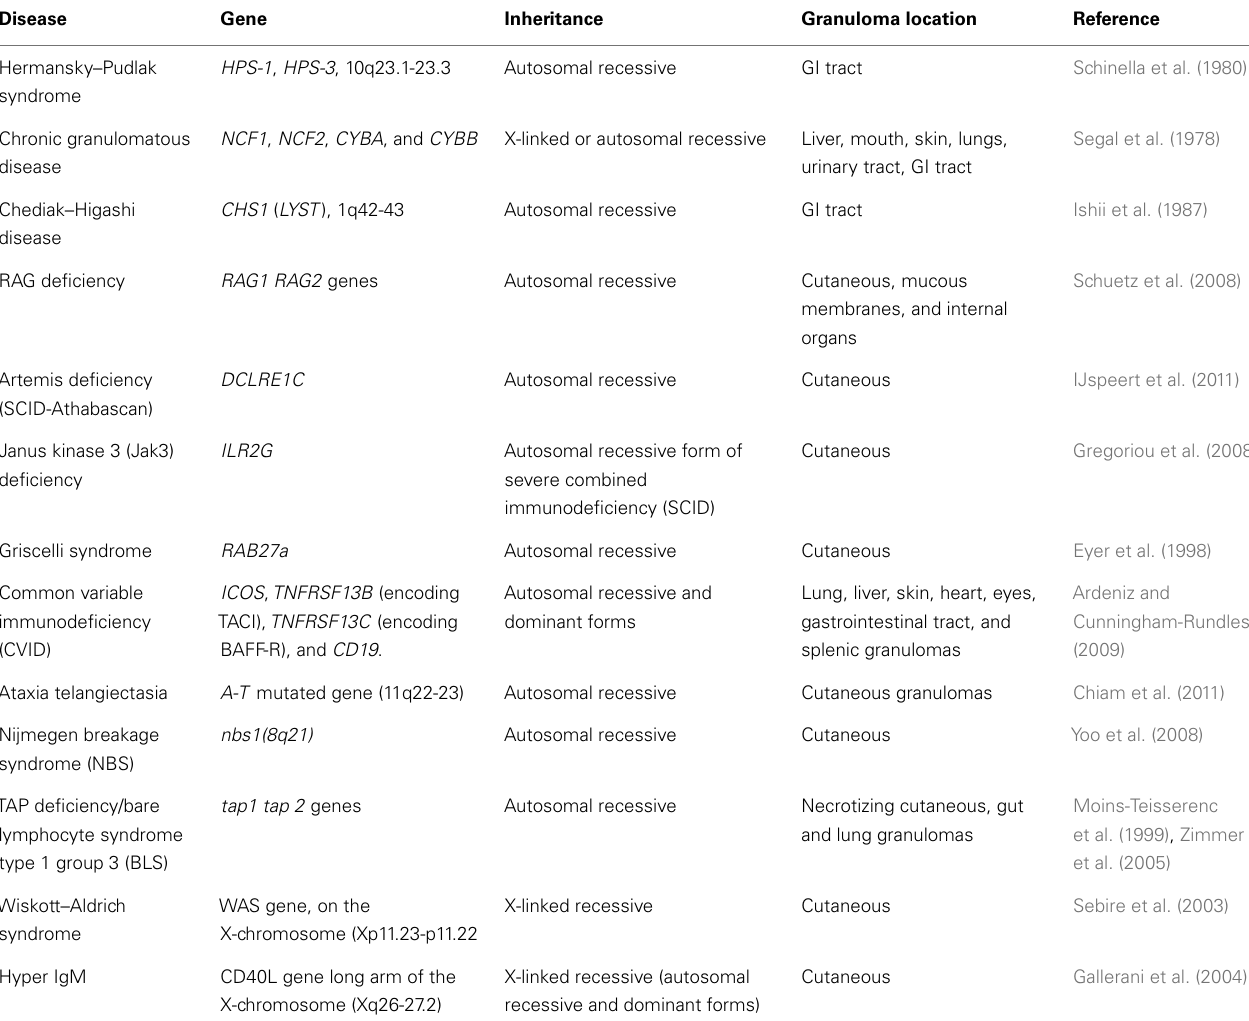
Table 2 | Immunodeficiency disorders that present with granulomatous